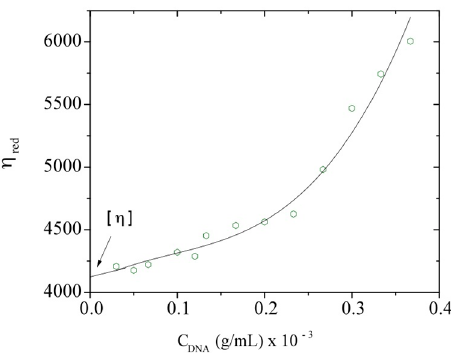
Figure 5. Reduced viscosity, η red , dependence with C DNA at a temperature of 20 °C. The solid line represents only a visual aid.